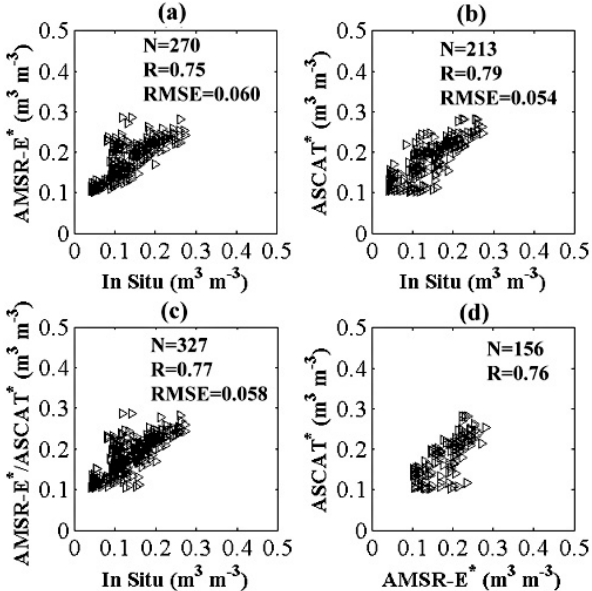
Fig. 6. Comparisons of in situ and rescaled/merged satellite-based soil moisture were conducted. The grid cell is the same as Fig. 2. Relationships between in situ and (a) rescaled AMSR-E (AMSR- E*), (b) ASCAT (ASCAT*) and (c) merged AMSR-E* and AS- CAT* (AMSR-E*/ASCAT*). (d) Relationship between AMSR-E* and ASCAT*.